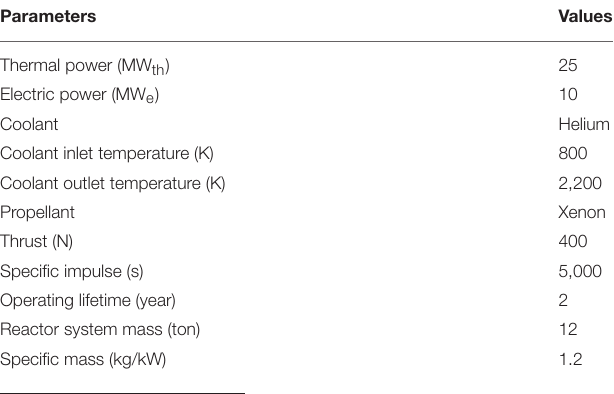
TABLE 1 | Main parameters of the whole